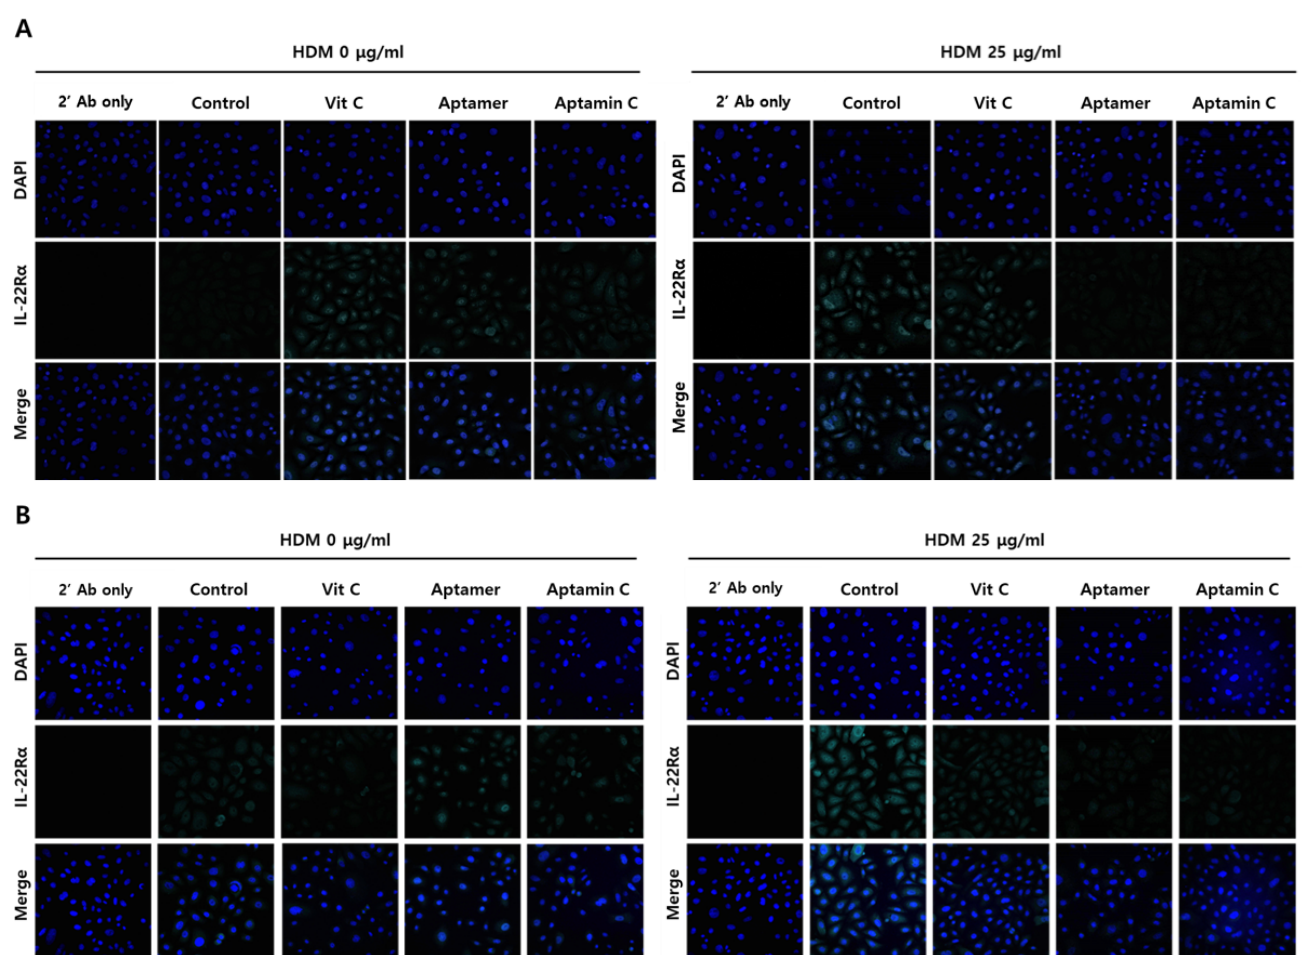
Figure 3. Effects of HDM extract on IL-22R α expression by HaCaT and primary keratinocytes, and suppression by Aptamin C. ( A ) HaCaT and ( B ) primary keratinocytes were pre-treated with HDM (25 µ g/mL) for 24 h, fixed with 4% paraformaldehyde (PFA), and pre-incubated with 5% goat serum in PBS-T. The cells were incubated with anti-human IL-22R α antibody (1:150) or vehicle and with Alexa Fluor 633-conjugated anti-rabbit secondary antibody (1:1500), followed by nuclear staining with 4’,6-diamidino-2-phenylindole (DAPI; blue). Fluorescence microscopic images were captured and analyzed by confocal microscopy. Results are the representative of three independent experiments.